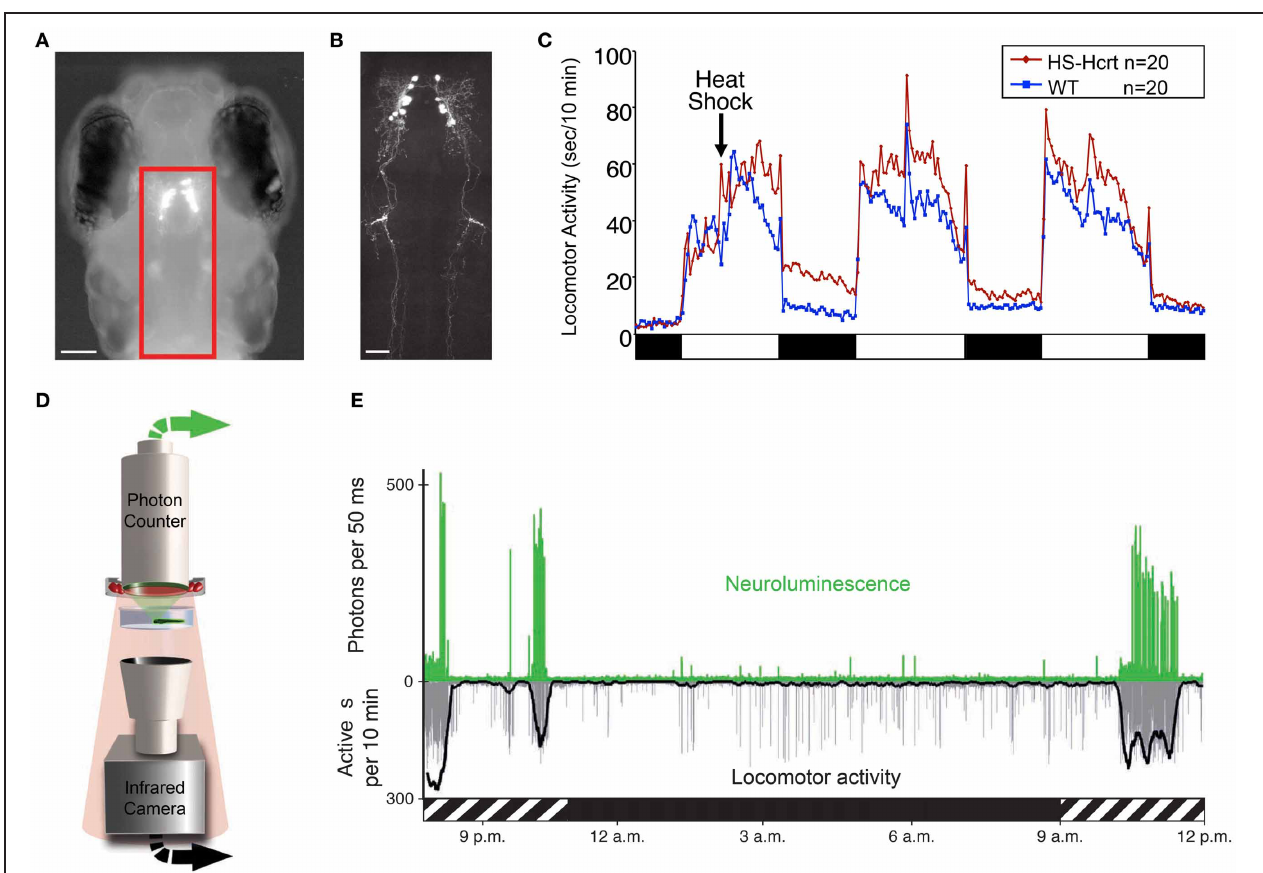
infrared (IR) lights and an IR camera that is placed below the recording chamber. Spectral separation between GA neuroluminescence and the IR illumination allows the simultaneous recording of GA neuroluminescence and larval behavior. (E) Activity of Hcrt neurons during natural behavior. Data for a representative 4 dpf larva is shown. The larva exhibited periods of increased spontaneous locomotor activity (lower trace, thick line indicates 10min running average) during the subjective day (hatched bar below graph) and little activity during the subjective night (black bar below graph). Most neuroluminescence signals produced by Hcrt neurons (upper trace) coincide with periods of robust locomotor activity during the subjective day, suggesting that Hcrt neuron activity is associated with arousal. Figure modified from Prober et al. (2006), Naumann et al.